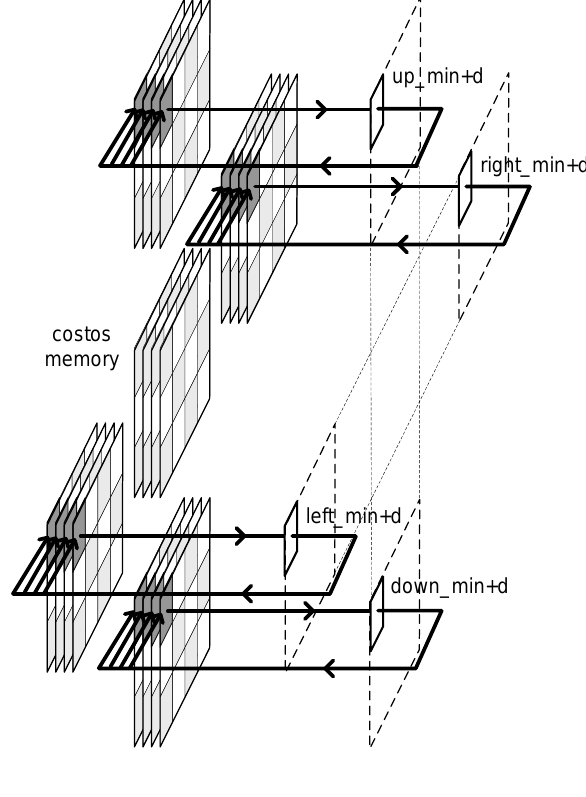
Figure 7. Diagram of the smoothing